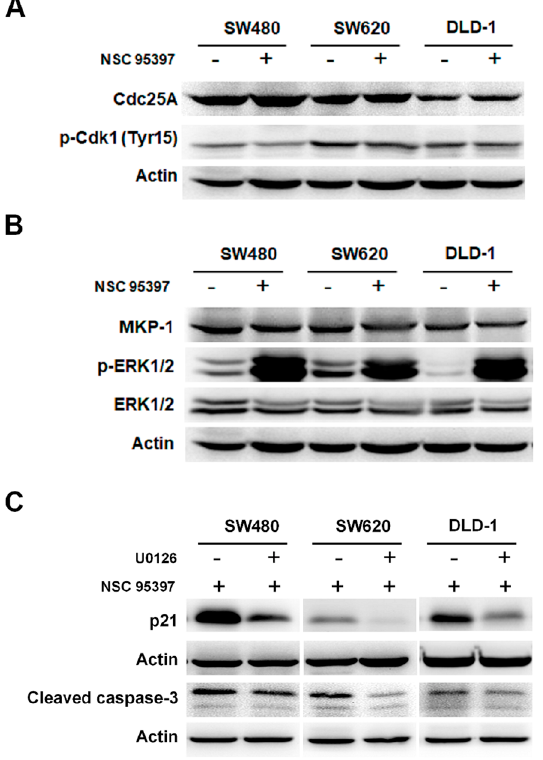
Figure 5. Involvement of MKP-1/ERK1/2 pathway in NSC 95397-induced p21 expression and caspase-3 activation in human colon cancer. Representative Western blots showing ( A ) the expression of Cdc25A, the phosphorylation of Cdk1 at Tyr15; ( B ) the expression of MKP-1 and ERK1/2, and the phosphorylation of ERK1/2 at Thr202/Tyr 204 in SW480, SW620, and DLD-1 cells treated with 10 µ M NSC 95397 for 6 h, with actin as loading control; ( C ) representative Western blots showing expression of p21 and cleaved caspase-3 in colon cancer cells that were pre-incubated with 20 µ M U0126 for 2 h and then treated with 10 m µ M NSC 95397 for 6 h.